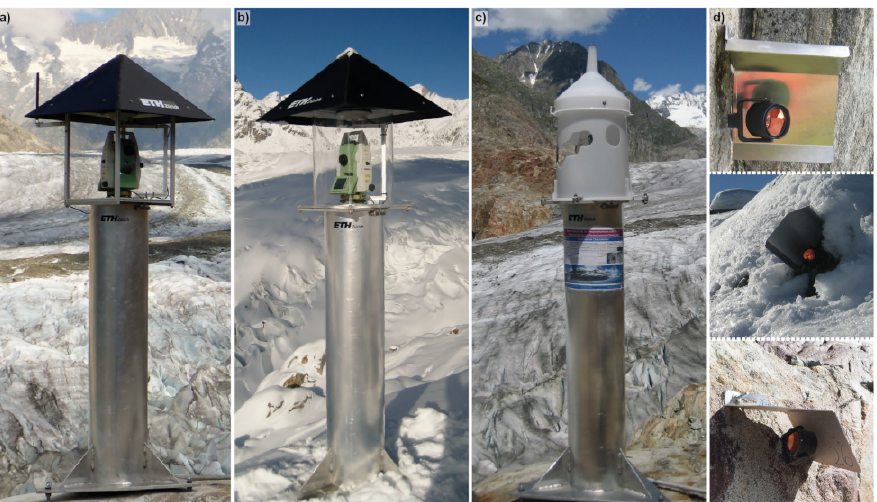
Figure 4. Total station monitoring setup in the high alpine environment of the Great Aletsch Glacier with different, tested protection equipment. ( a ) Aluminum pillar at Chatzulecher with PMMA windows and polyamide roof; ( b ) aluminum pillar at Chatzulecher with PMMA cylinder and ( c ) aluminum pillar at Chatzulecher with an opaque polyamide cylinder and holes for unobstructed measurements; ( d ) protection of prisms used at Aletsch for high snow loads and heavy rainfall; proof of function of the protection roof during harsh winter conditions; less stable roof bent down by rockfall and/or snow